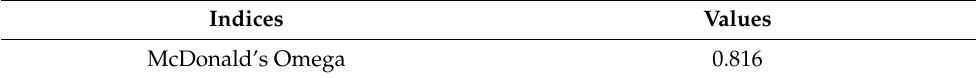
Table 7 reflects reliability indicators for the single-dimensional structure composed by seven items, evaluated by McDonald’s Omega. Table 7. Reliability indices for each